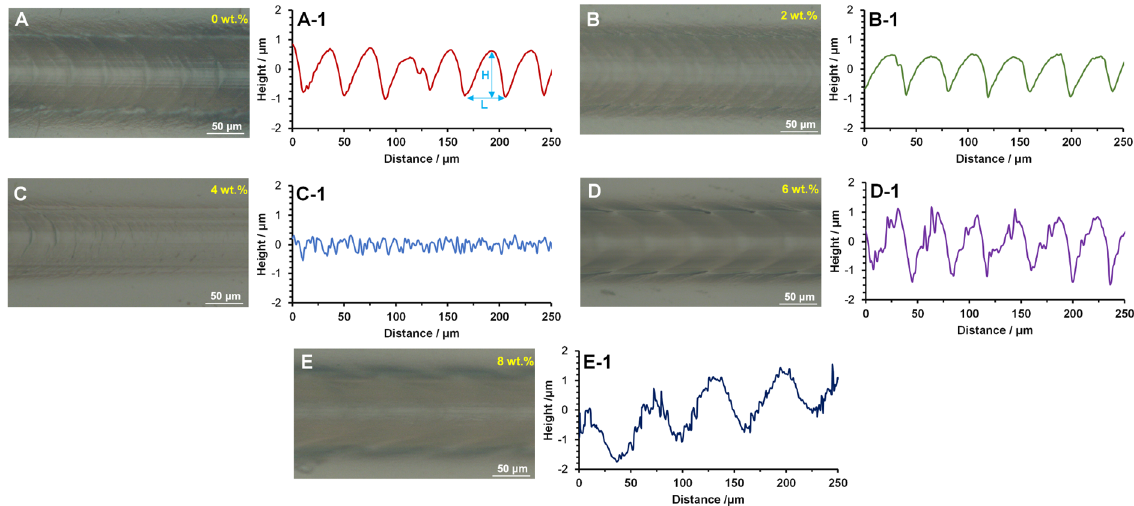
Figure 6. The ripple deformation response of the HDPE composites with different Si 3 N 4 contents: ( A , A-1 ) are 0 wt.%; ( B , B-1 ) are 2 wt.%; ( C , C-1 ) are 4 wt.%; ( D , D-1 ) are 6 wt.%; ( E , E-1 ) are 8 wt.%. The ripple deformation represents the accumulation and distribution of the sliding stress, and the stick-slip motion is periodic in nature. The intrinsic mechanical properties of HDPE, such as its yield and post-yield responses, determine the resistance of the polymer to deformation, thus influencing the ripple deformation response. After the yield point is reached, a process known as strain-softening allows stress to localize, thus generating the initial deformation; any subsequent increase in stress (strain-hardening) distributes the localized stress and completes the deformation (Figure 3). In this case, the low strain- softening and high strain-hardening exhibited by the 4 wt.% Si 3 N 4 composite ensure that the low accumulated stress can be distributed more evenly, leading to the generation of a ripple deformation with a low height (H) and length (L) (Figure 7). In contrast, increased strain-softening and low strain-hardening with higher contents of Si 3 N 4 (6 wt.% and 8 wt.%) result in more localized stresses that cannot be dispersed. As a result, more strains create a greater accumulation of material and noticeable ripples.